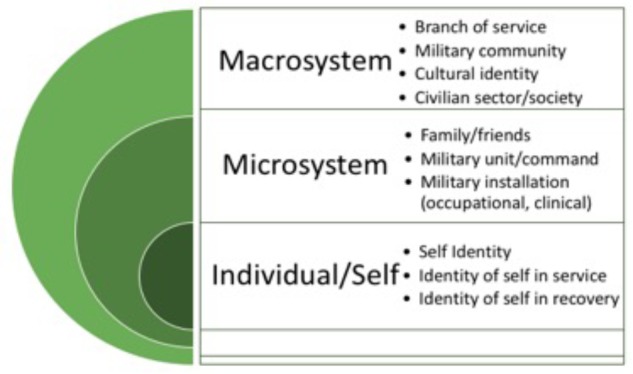
Systems of social transformation for service members (based on Bronfenbrenner, 1977).